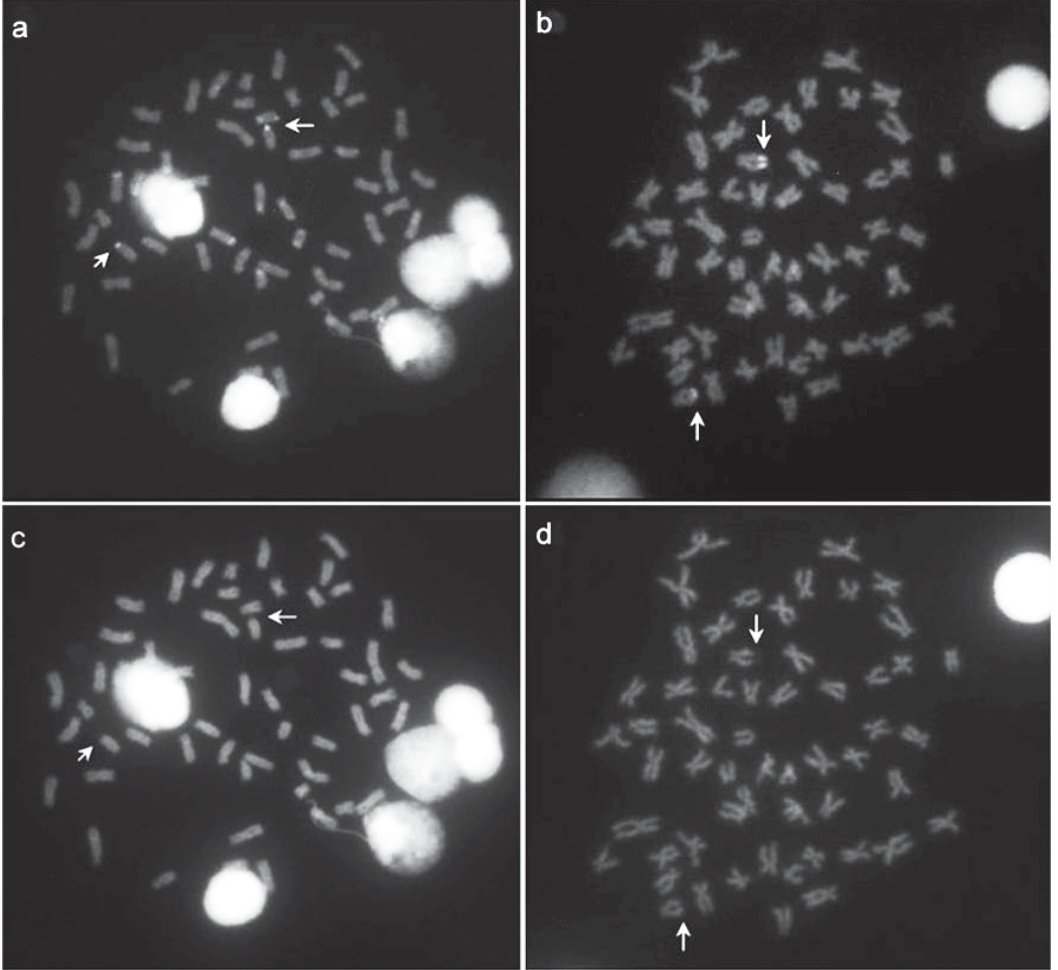
Fig. 2. Somatic metaphases of Parapimelodus nigribarbis : (a) CMA DAPI. The arrows indicate the Ag-NOR-bearing pair of